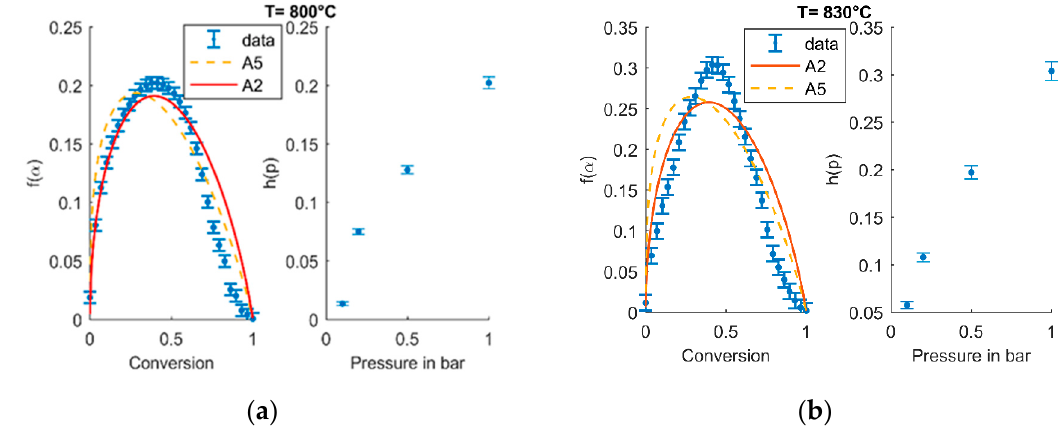
Figure 10. Best fitted models (A2 = continuous red line, A5 = yellow dashed line) to the experimental data and the impact of the pressure on the kinetics by non-parametric kinetics (NPK) at 800 °C ( a ) and at 830 °C ( b ).